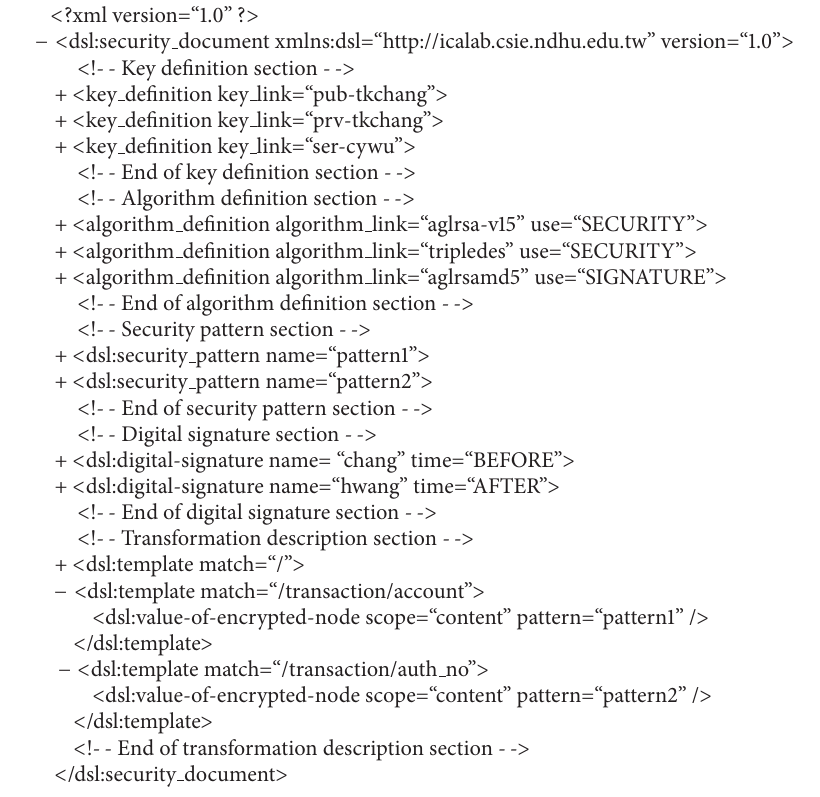
Algorithm 1: An example of a document security